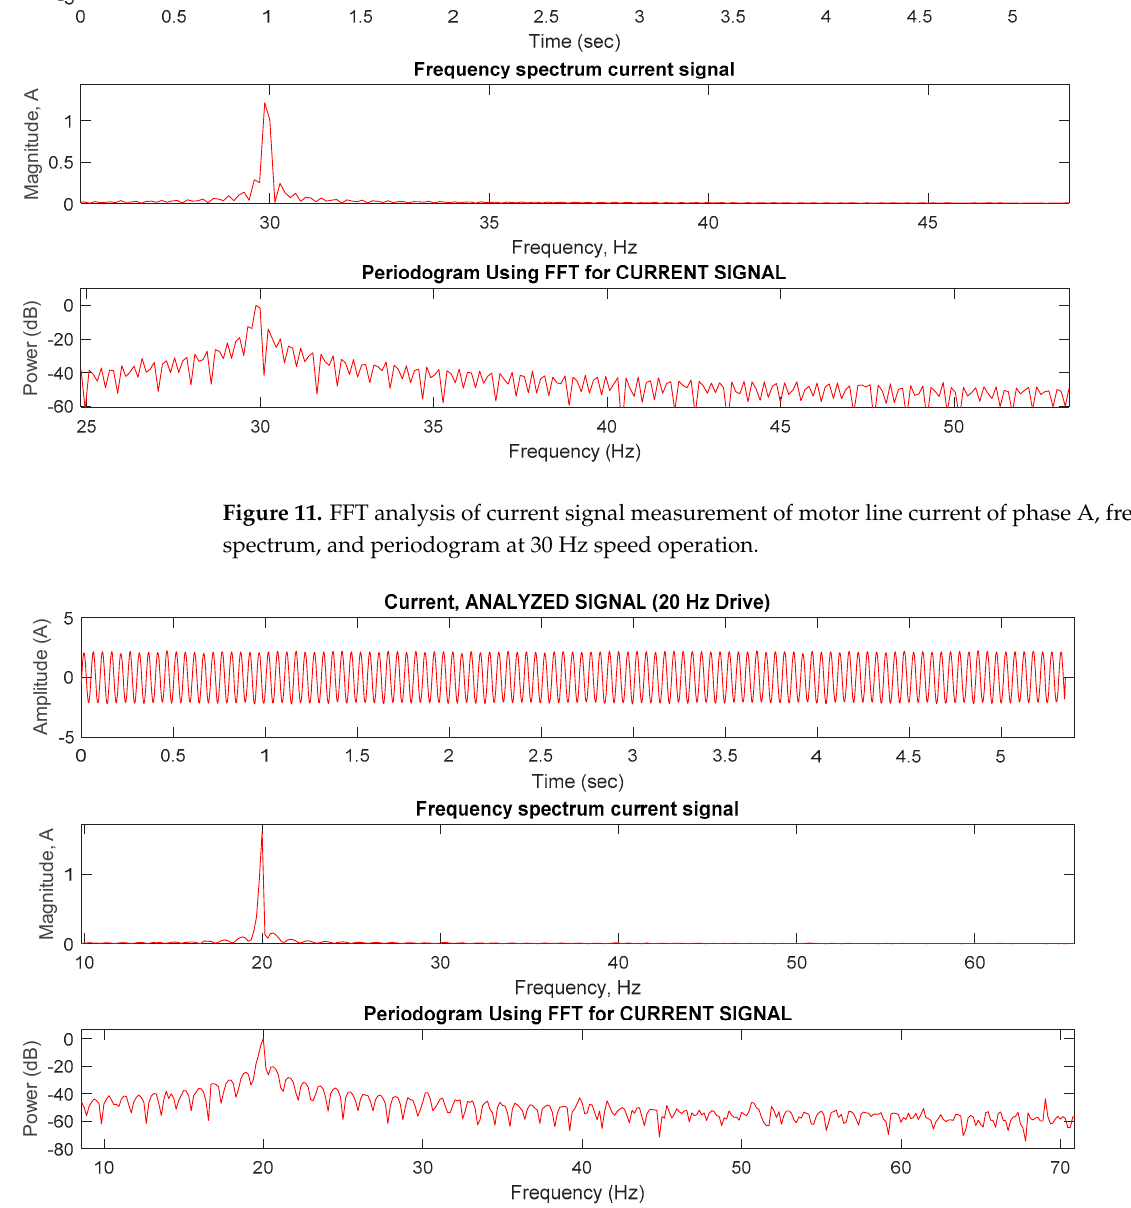
Figure 13. FFT analysis of current signal measurement of motor line current of phase A, frequency spectrum, and periodogram at 10 Hz speed operation. As shown in FFT spectrum and periodogram from Figures 8–13 and Table 5, frequen- cies presented in Table 4 are not detected for each VFD speed operation condition, only the fundamental frequency is detected. This occurs mainly due to the closeness of the fre- quencies to the fundamental frequency, where more signal data are required (at least 10 s) so the FFT could detect the sideband frequencies. The periodogram is included because it is used to highlight the sideband frequencies in dB, which is the unit where a severity of a faulted rotor of RCIM can be measured, as it is presented in Table 1. Hence, one of the disadvantages of the FFT analysis for OTD for RCIM, is that it is not possible for the de- tection of the BRB sbf with less than 10 s of recorded current signal, where it is evident in